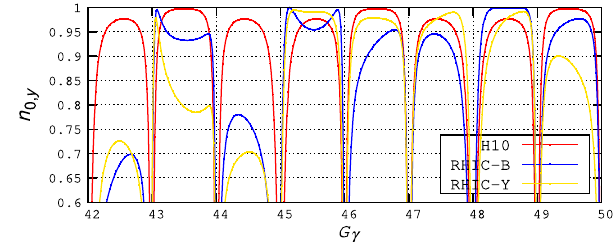
FIG. 22. Transmission of ⃗ n 0 from AGS H10 extraction septum to RHIC injection kickers, over the range G γ ∈ ½ 42 ; 50 (cid:3) , from numerical simulation. The graph displays ⃗ n 0 ;y ð G γ Þ at three different locations: H10 and the RHIC Blue and Yellow ring kickers. In this simulation, the periodic spin precession axis ⃗ n ð G γ Þ at the extraction septum in the AGS ring is computed 0 using the AGS partial snakes OPERA field maps [15].